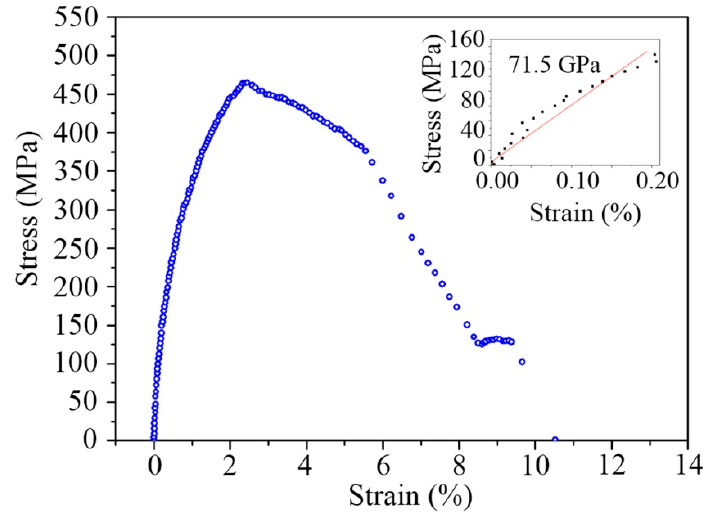
Figure 13. Stress–strain curve of an Al film with thickness of 510 nm.